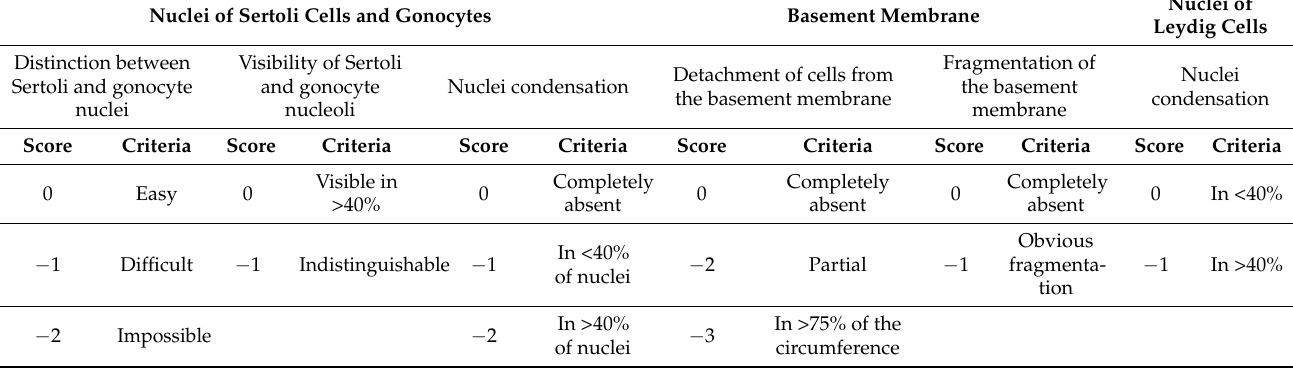
Table 1. A semi-quantitative scoring system for the assessment of integrity and the structural changes of cultured testicular tissue